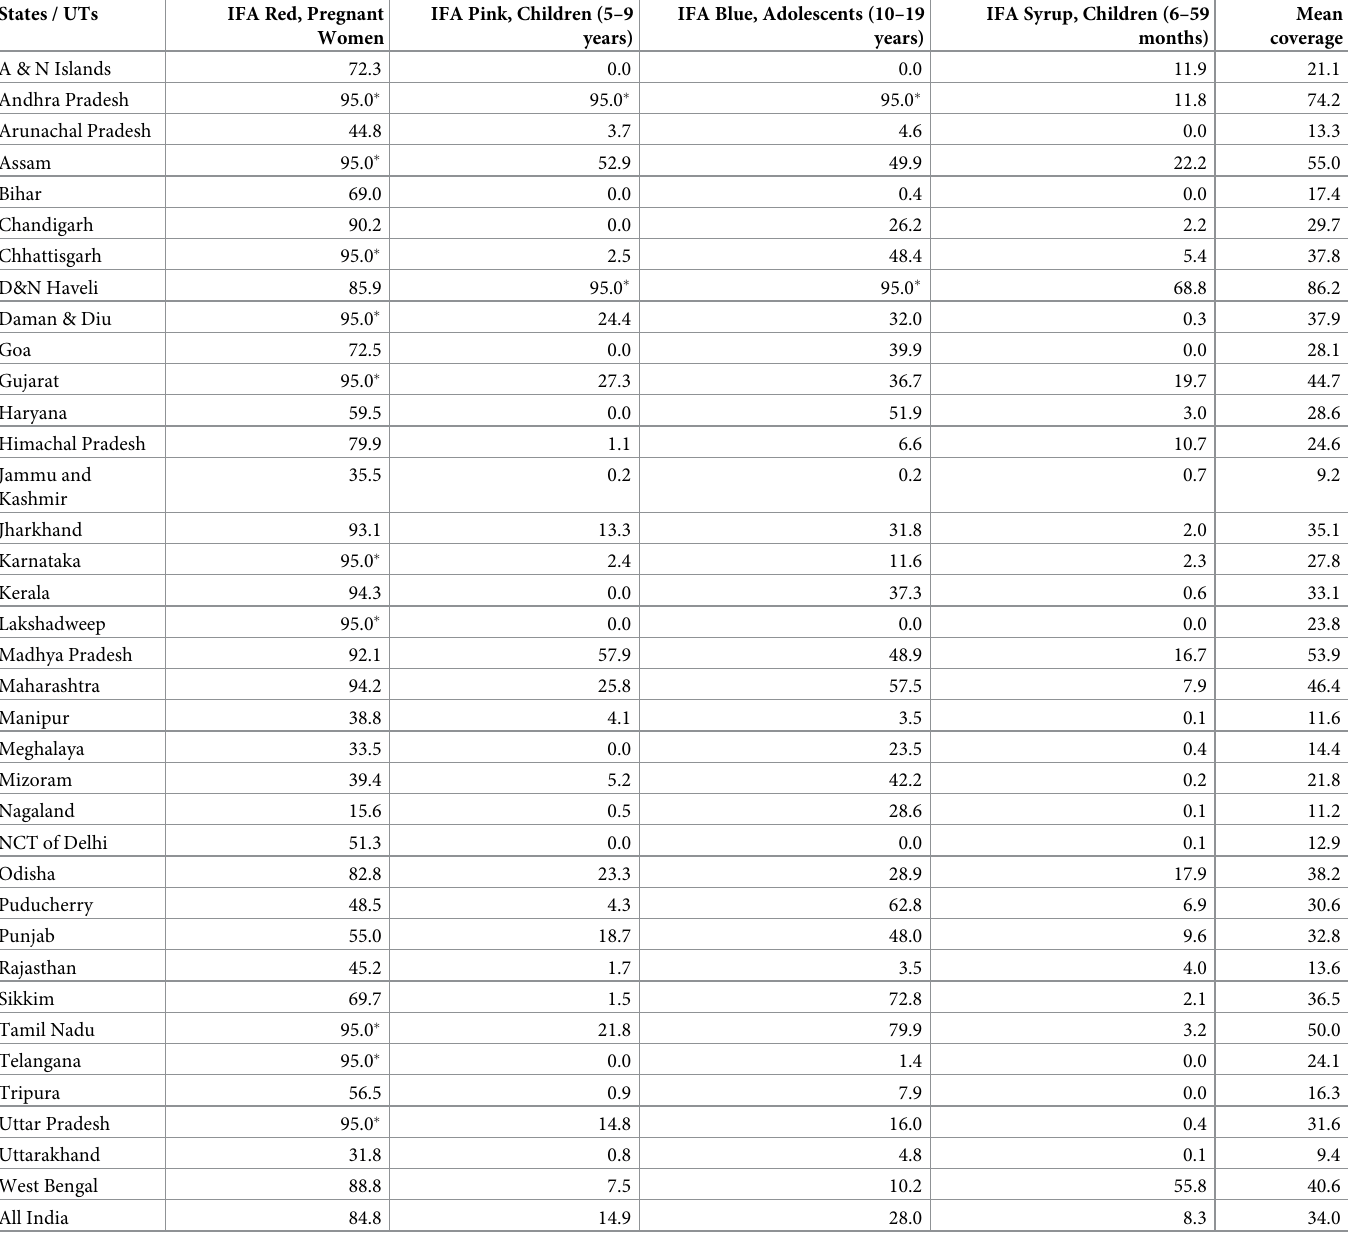
Table 1. IFA supplementation coverage by beneficiary groups by states/UTs, HMIS 2018–19. States /